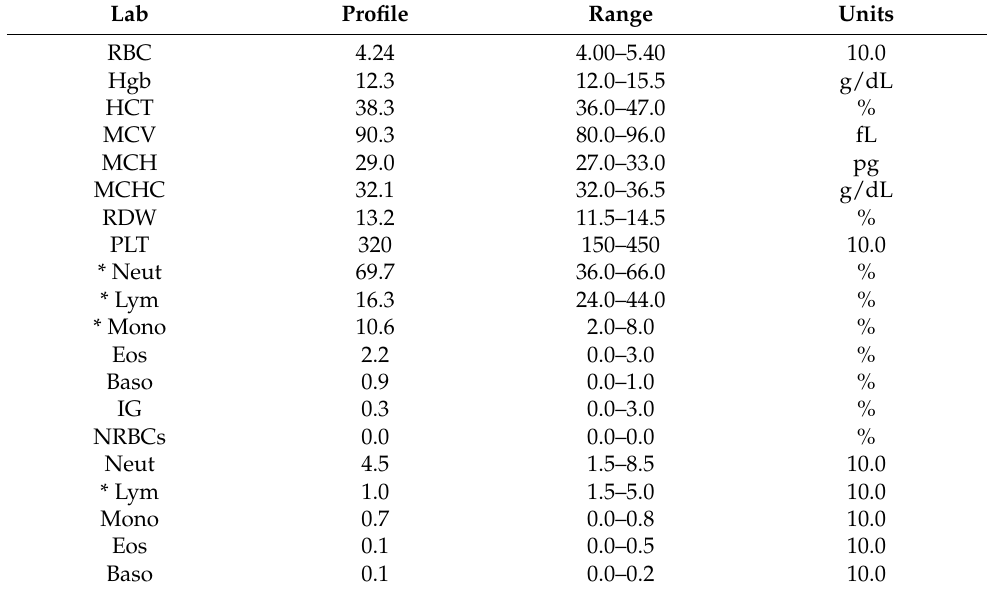
Table 1. Complete blood count with differential taken 7 months after completing primary series of